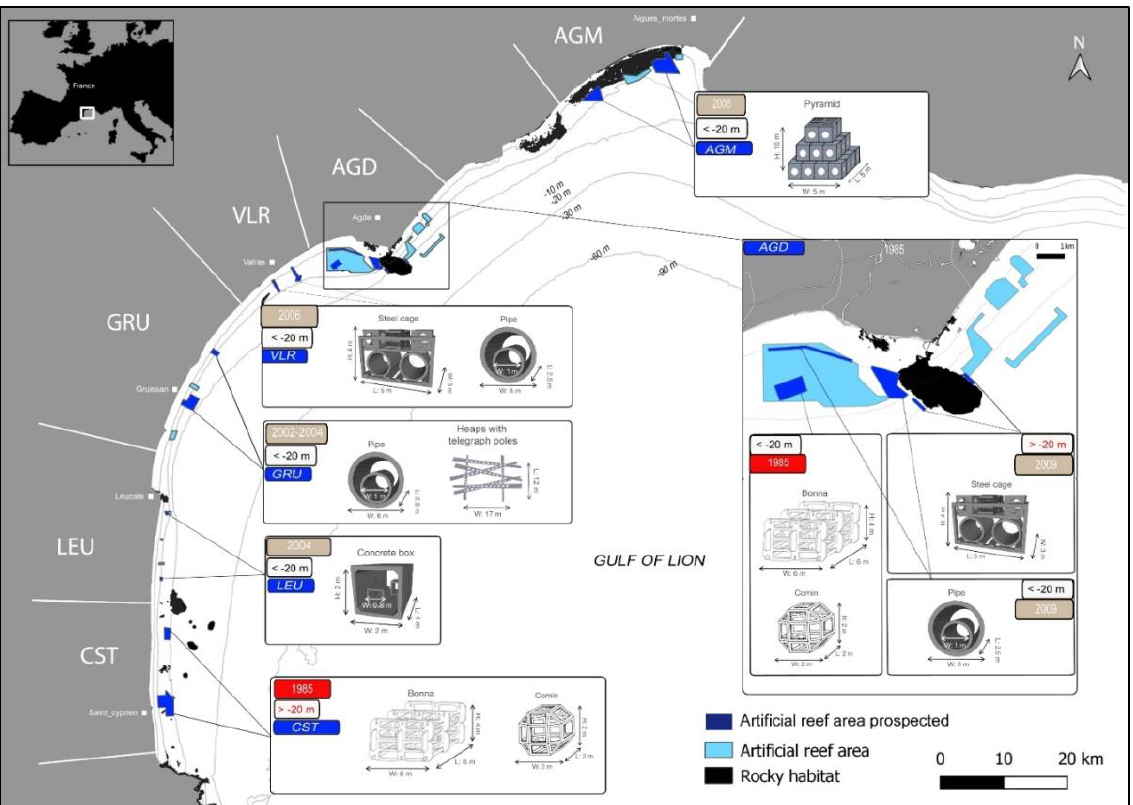
Figure 1: Map showing the layout of the 6 geographical sectors (AGM, AGD, VLR, GRU, LEU, CST) and the 16 sites prospected (indicated in dark blue) for artificial reef sampling. Areas indicated in light blue corresponded to artificial reef deployment areas. Areas indicated in black corresponded to natural hard- substrate areas. Some of the AR shape illustrations were taken from Tessier et al.,